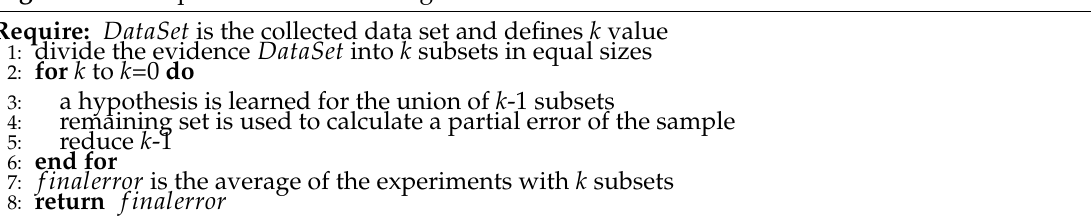
Algorithm 2 Simple cross-validation algorithm.